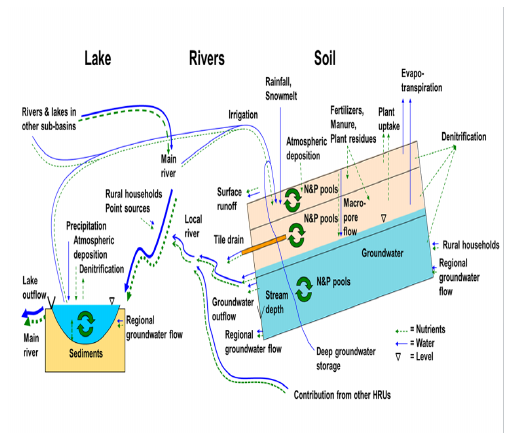
Fig. 1: Schematic description of HYPE model.